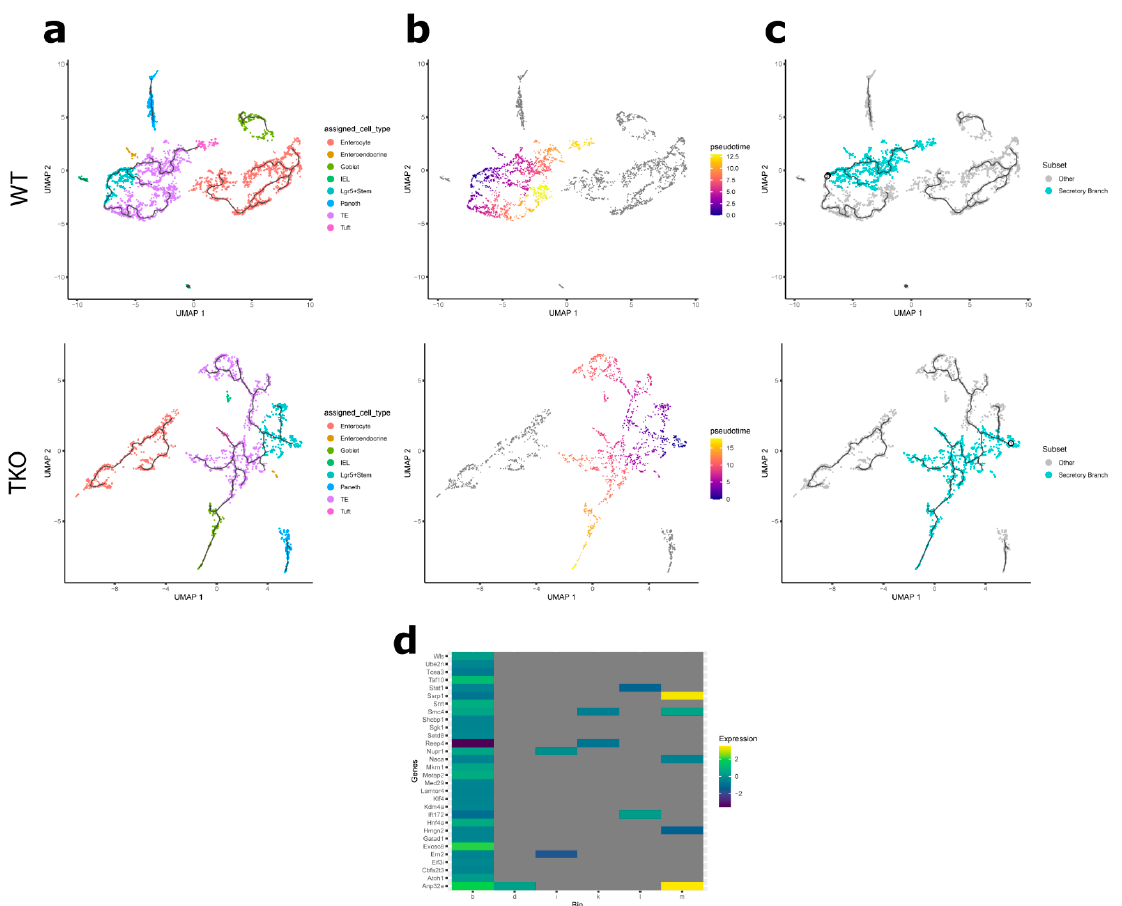
Figure 2. Identifying differentially expressed genes through pseudotime binning. ( a – c ) UMAP plots, black lines represent branched cell trajectories; ( a ) cells colored by cell type; ( b ) cells colored by pseudotime; ( c ) cells colored by selected branch for downstream analysis (blue); ( d ) heatmap of regression analysis slope values ( β 0 ) by genes determined to regulate expression by gene ontology analysis. p < 0.05 for all genes shown. 3.3. Nupr1, Kdm4a, and Gatad1 Are Possible Novel Regulators of Secretory Cell Fate To investigate the kinetics of transcriptional regulators across pseudotime, the branch representing secretory precursors was chosen for further analysis based on the enriched goblet cell count in Tipe0 − / − intestine. Following subsetting, expression of each gene was fit to pseudotime across the branch in either genotype and the fits between each genotype were compared. This identified nine genes that were differentially expressed both across pseudotime within each genotype and between genotypes. Five genes (Nupr1, Klf4, Atoh1, Kdm4a, and Gatad1) were identified in having roles specific to differentiation (Figure 3). Plotting the polynomial fit of expression across pseudotime revealed that most of these genes demonstrated a point at which the slope of Tipe0 − / − diverged dramatically from that of the WT (Figure 3a,c). This change could represent a switch between expres ‐ sion programs responsible for cell fate decisions. Notably, in the TIPE − / − UMAP plot, gob ‐ let cells are at the end of the secretory trajectory whereas in that of the WT, tuft cells are the end of the trajectory. Therefore, it is possible that the differential expression of these genes is due to this difference in clustering. However, this does not rule out the possible